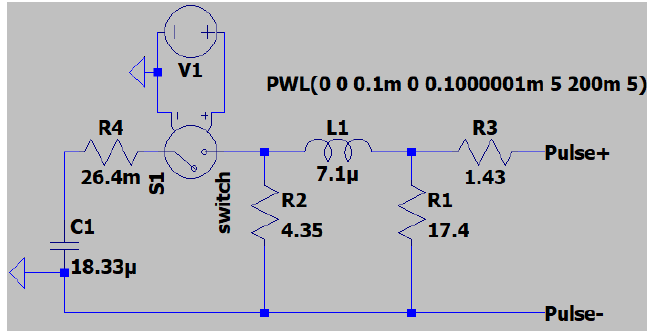
Figure 37. The pulse generating circuit used to demonstrate large-signal transient operation of the FCPVM. Developed from [18].